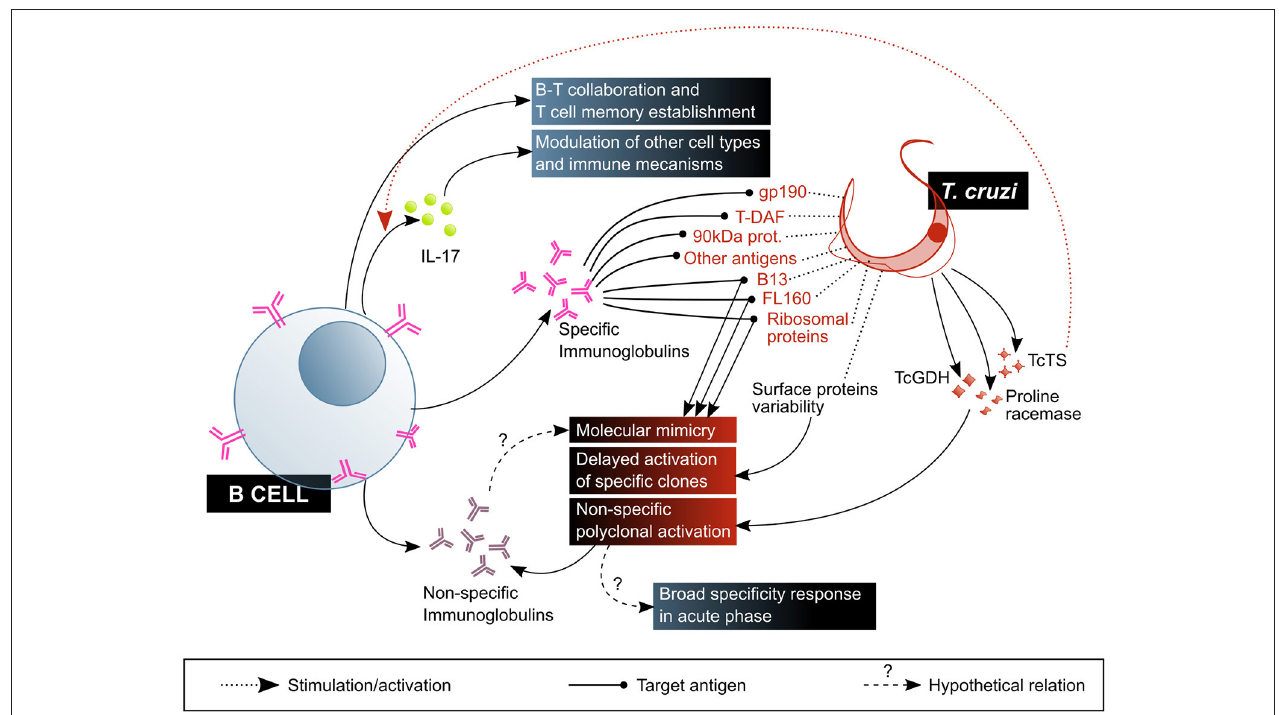
FIGURE 5 | B cell-mediated response is central to the control of T. cruzi infection, but is also affected by parasite mechanisms that favor its escape and are associated with pathogenesis. The beneficial factors for the host are highlighted in blue shaded boxes, while the factors considered harmful to the host are shown in red shaded boxes. T-DAF, trypomastigote decay acceleration factor; TcTs, T. cruzi Transialidase; TcGDH, T. cruzi Glutamate dehydrogenase.